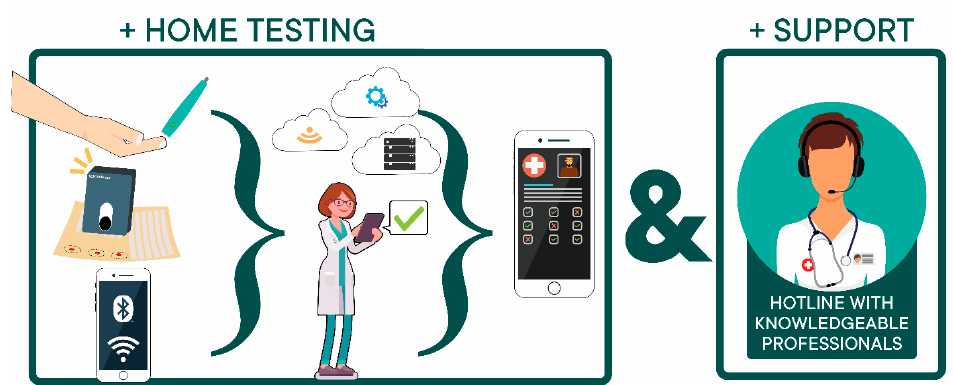
Figure 6. Flowchart of the use of an Android smartphone for image processing and paper ‐ based devices. In this example, the test is performed at home, the data collected from the paper ‐ based device through the Android application, and adequate software is sent to qualified medical personnel to support the management of the results obtained .